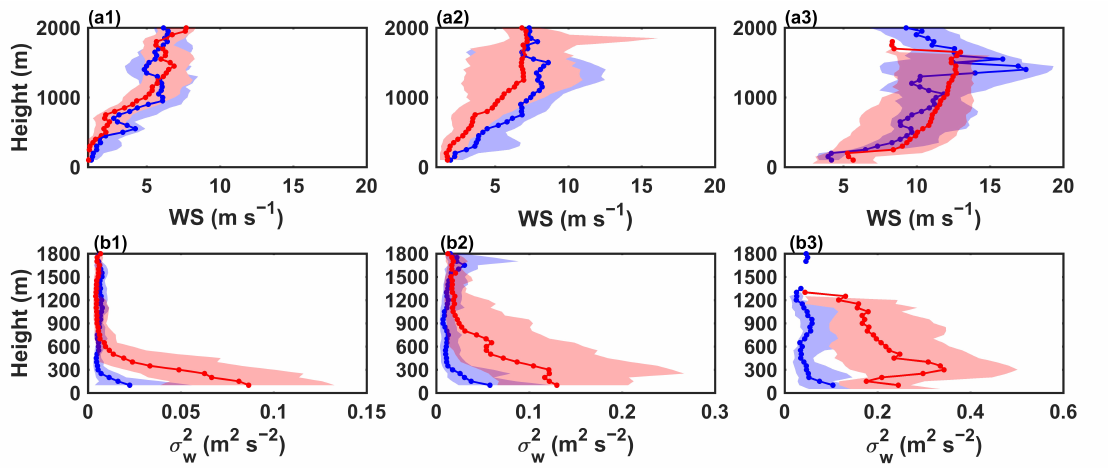
Figure 9. Mean diurnal cycles of WS, ( a1 , a2 , a3 ) and vertical variance vertical profiles ( b1 , b2 , b3 ), for weak, moderate, and strong wind classes, respectively. The shaded areas correspond to the interquartile range (25%–75%) during morning (blue) and afternoon transitions